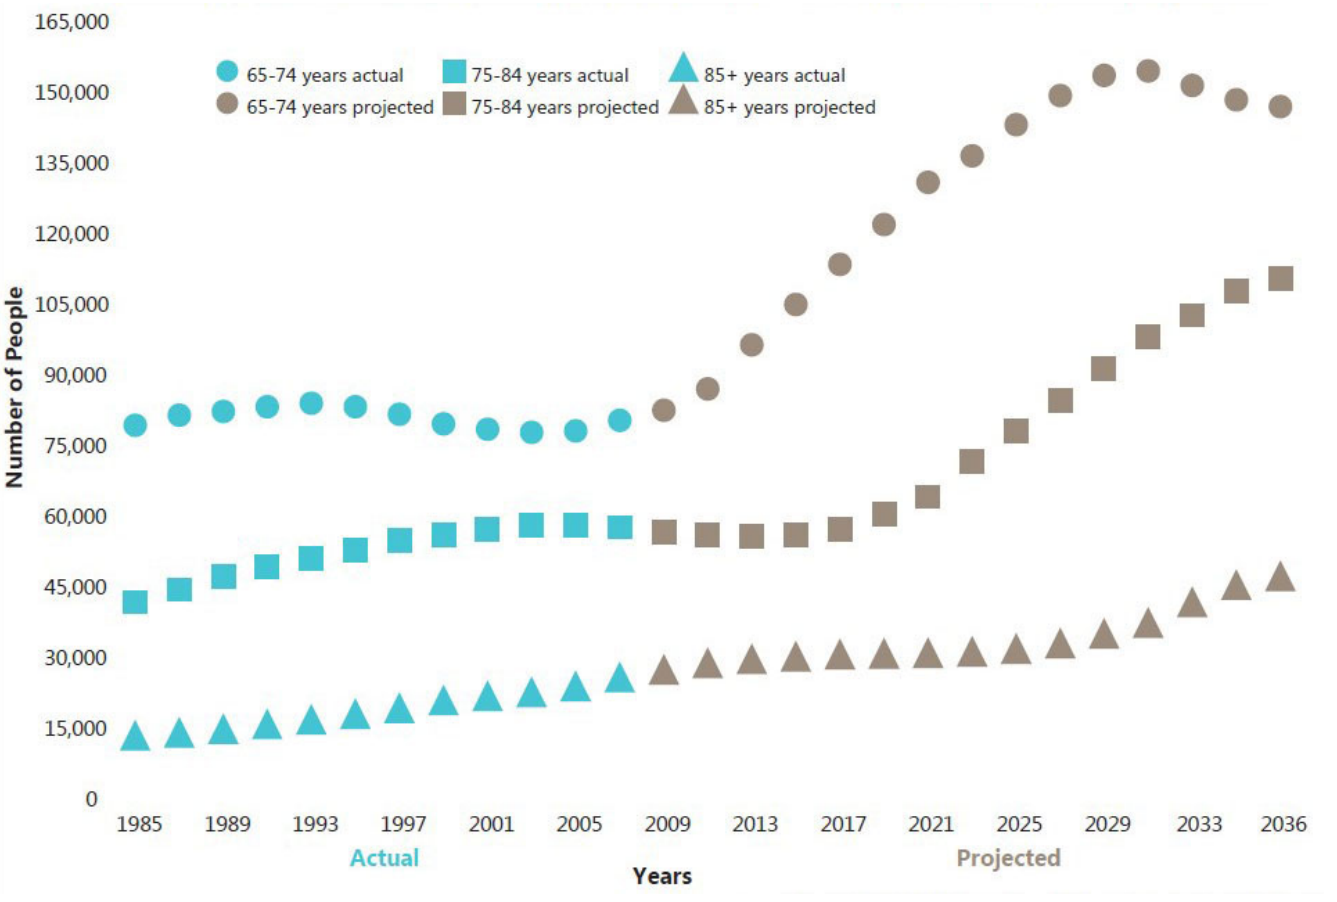
Figure 2: Actual and Projected Number of Older Adults Living in Manitoba, by Age Group